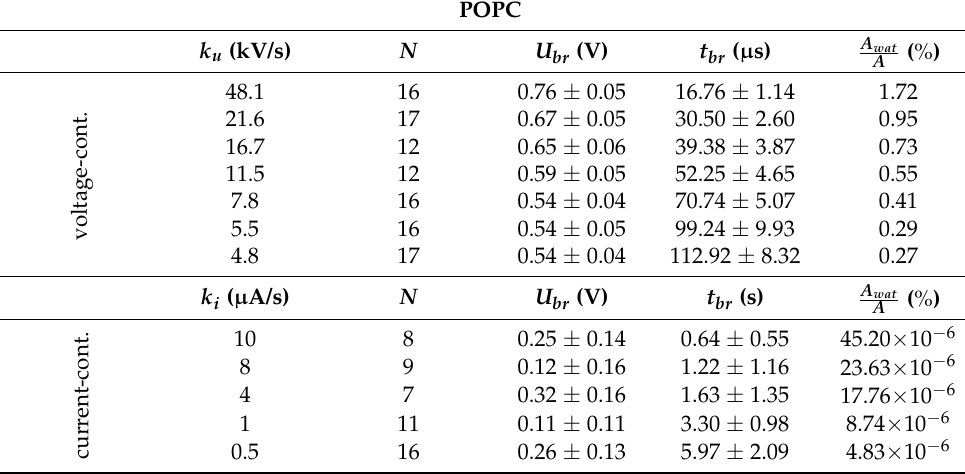
Table 2. Results for planar lipid bilayers composed of POPC. In the upper part of the table, the results of voltage-controlled measurements with seven different slopes k u are gathered while the results of current-controlled measurements with five different slopes k i are presented in the lower part of the table. For each slope of linearly rising signal, the planar lipid breakdown voltage U br and lifetime t br are presented. Values are given as means ± standard deviations. A wat fraction of the planar lipid bilayer that is occupied by pores. N is the number of experiments in each experimental